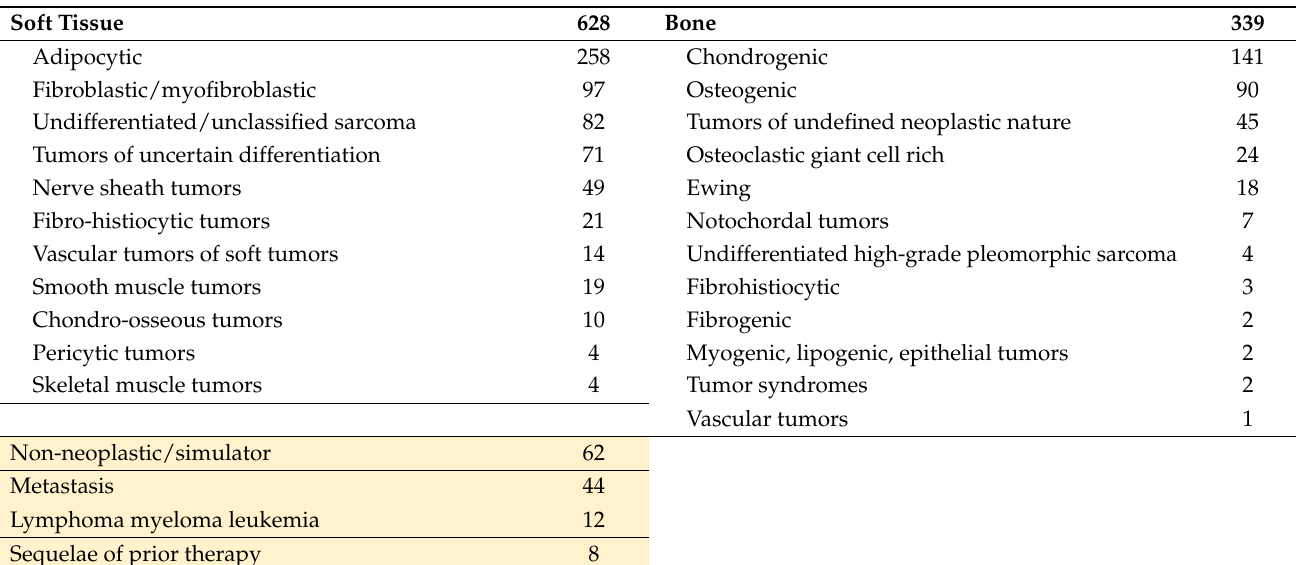
Table 1. This summary of all tumors included in the analysis over a 10-year period is split according to the diagnoses of the WHO classification.